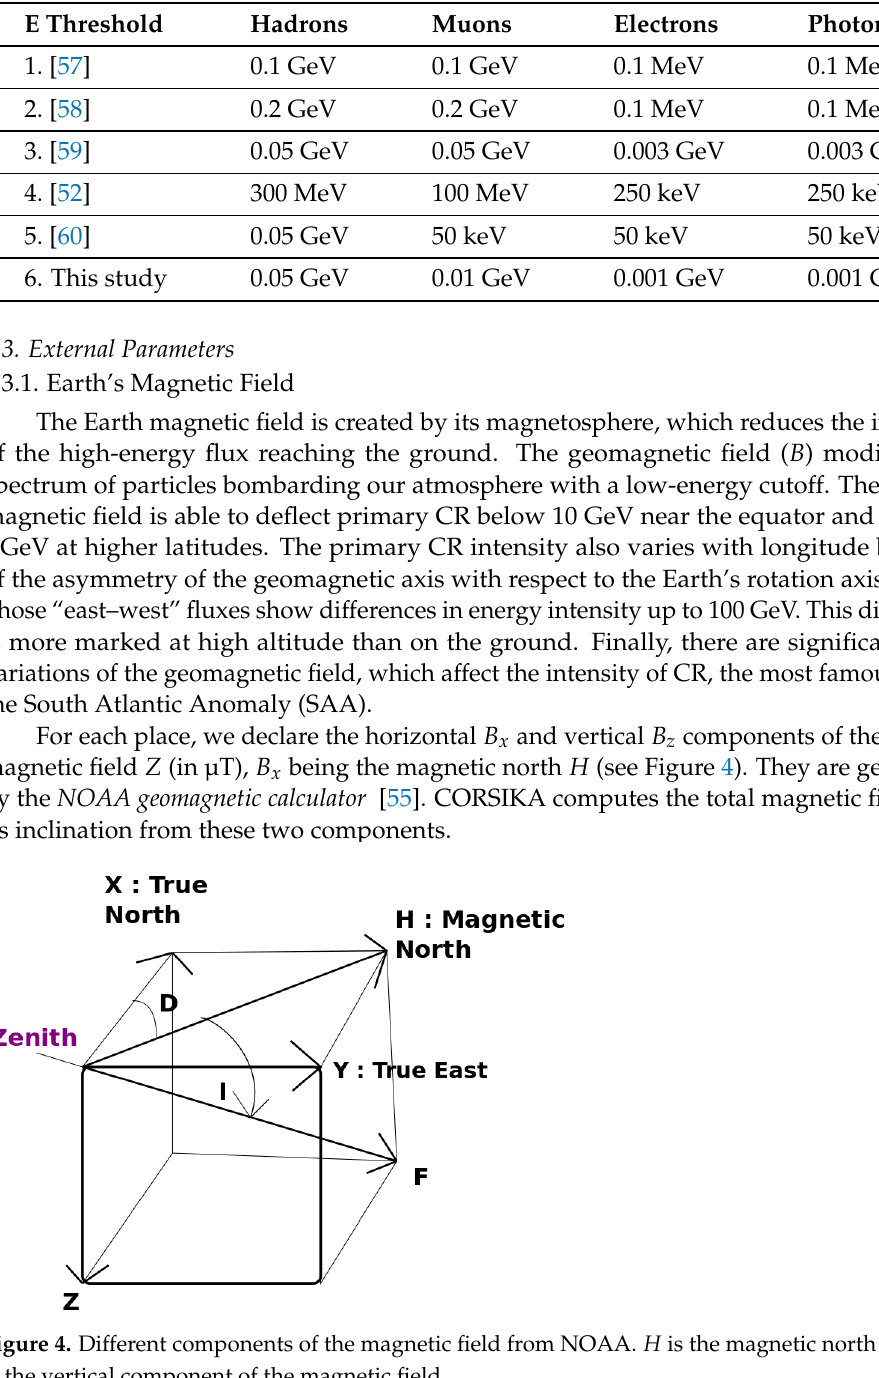
Table 1. Energy thresholds values used by different authors and for this study.